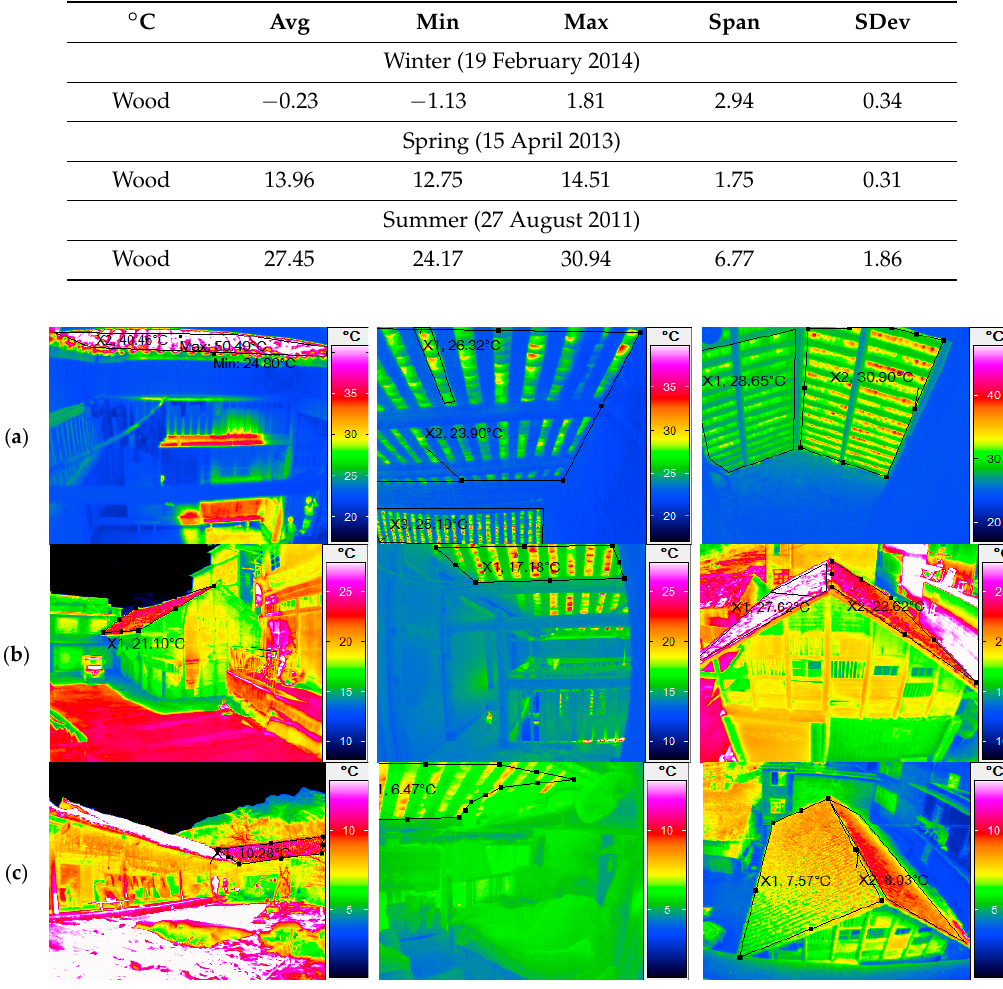
Figure 21. Thermographs of tiled roofs taken during: ( a ) summer at 11:00, ( b ) spring at 16:00, and ( c ) winter at